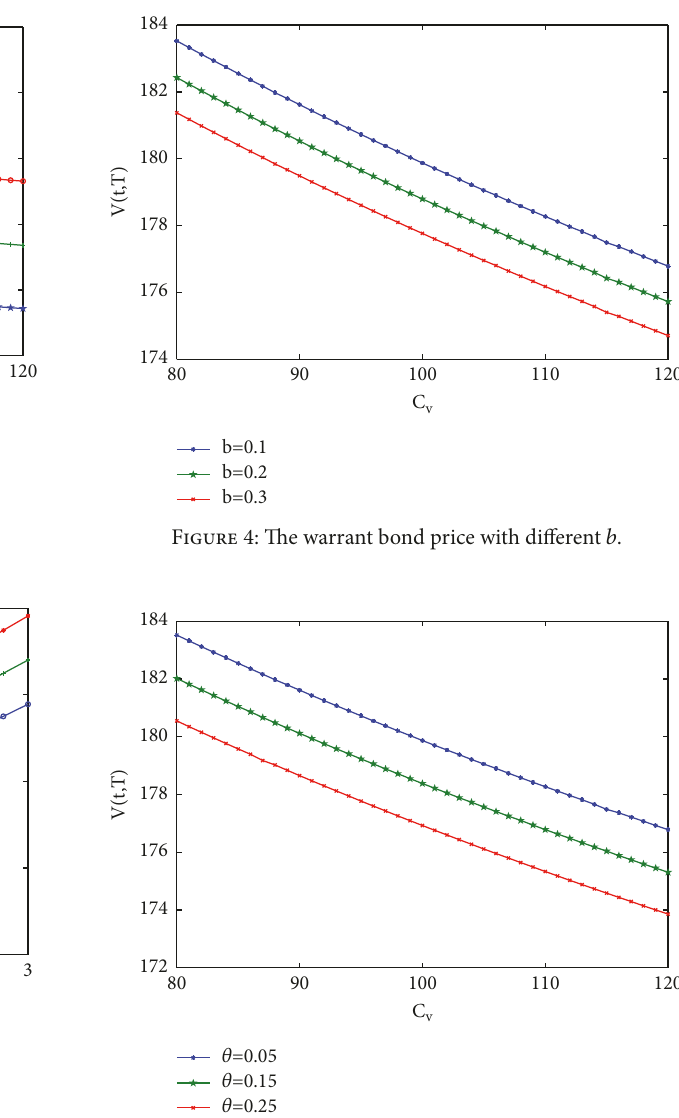
Figure 5: The warrant bond price with different 𝜃